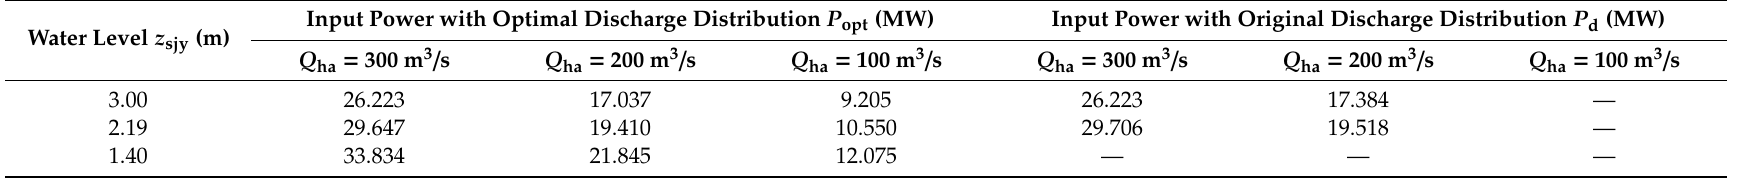
Table 7. Input power with optimal and original discharge distribution ratio.